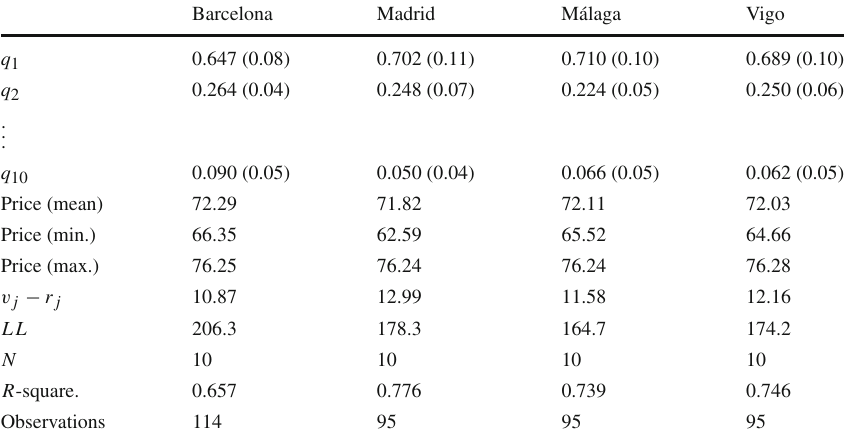
Table 7 Estimation results: occasional